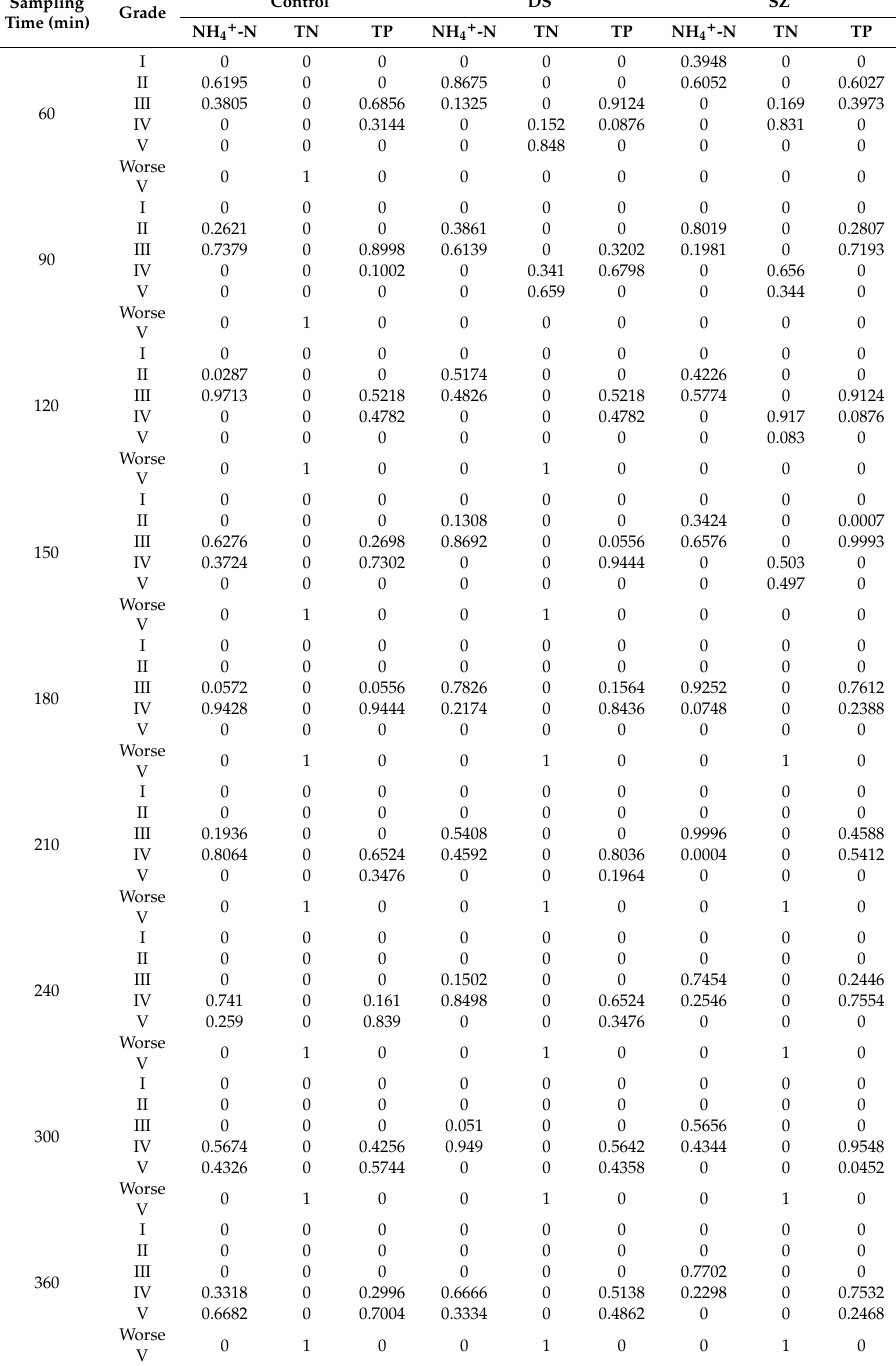
Table 4. The memberships of the pollution factors in water samples on the quality